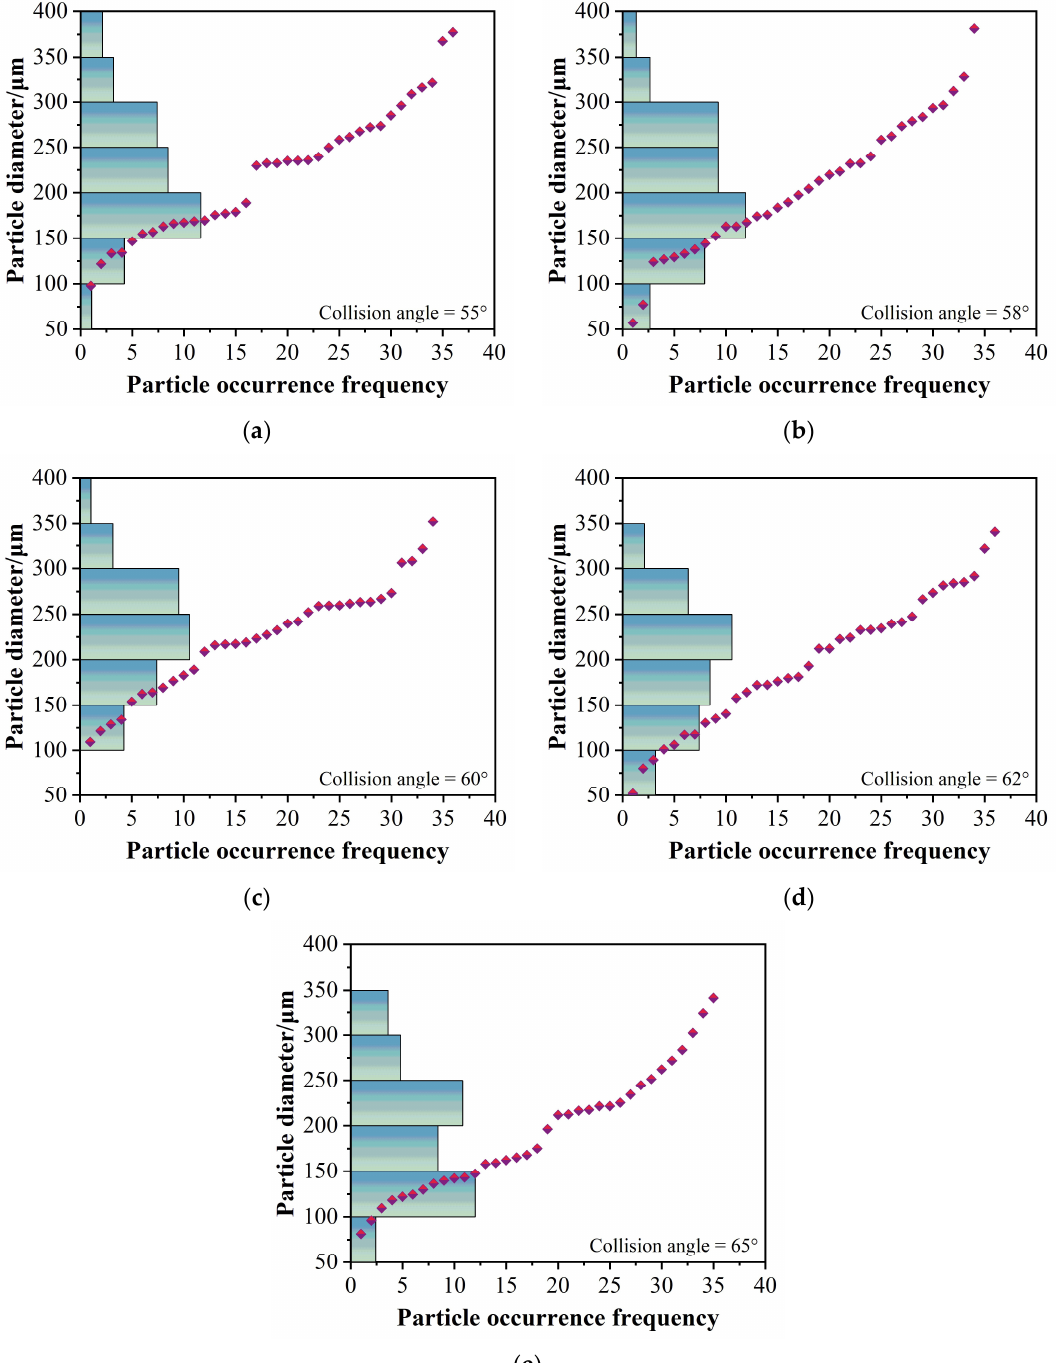
Figure 15. Spatial distribution of droplets in atomization field at different collision angles under injection pressure of 0.8 MPa. ( a ) Collision angle = 55 ◦ ; ( b ) Collision angle = 58 ◦ ; ( c ) Collision angle = 60 ◦ ; ( d ) Collision angle = 62 ◦ ; ( e ) Collision angle = 65 ◦